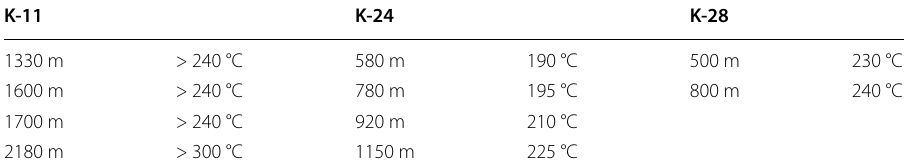
Table 1 In situ measurements of the temperature [°C] in the wells of Krafla (K) at specific depths [m] for permeable horizons presented in Guðmundsson and Arnórsson